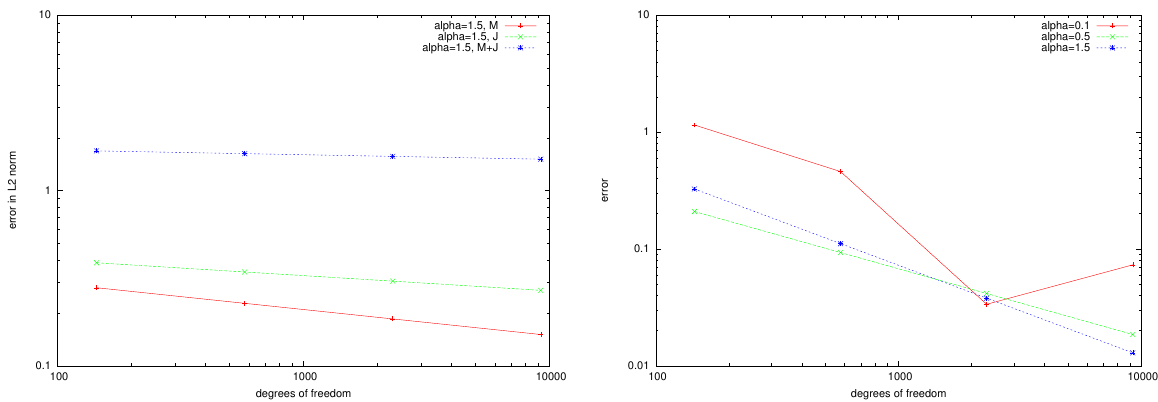
Figure 2. Errors in the L2-norm for α = 1.5 and the energy norm | C − C h | = O ( h η ) for α = 0.1,0.5,1.5. The convergence rates η , for α = 0.1 are, for the energy norm η C = 1.325363, and for the L 2 -norm η J = 1.617988 and η M = 1.184964. With α = 0.5, the energy norm of η C = 1.165255, the L 2 -norms of η J = 0.976440 and η M = 1.211619 and α = 1.5, for